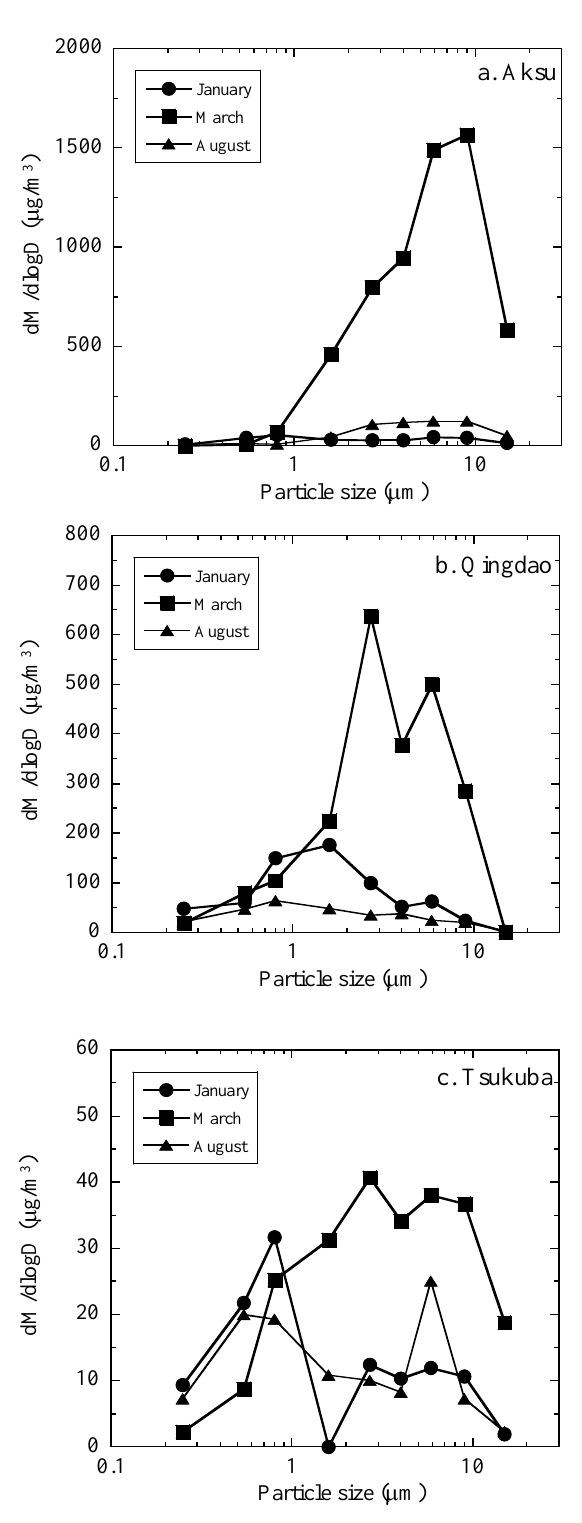
Fig. 2. Mass distributions of aerosols of various particle sizes in